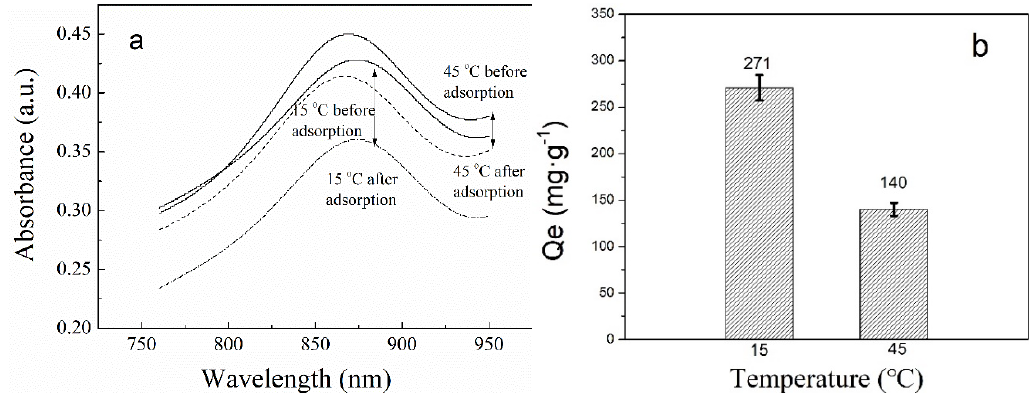
Figure 10. The UV-vis absorption spectra of phosphate solutions before and after adsorption ( a ) and phosphate adsorption capacity of PNIPAM/SiO 2 particles ( b ) at 15 and 45 °C (pH = 7).